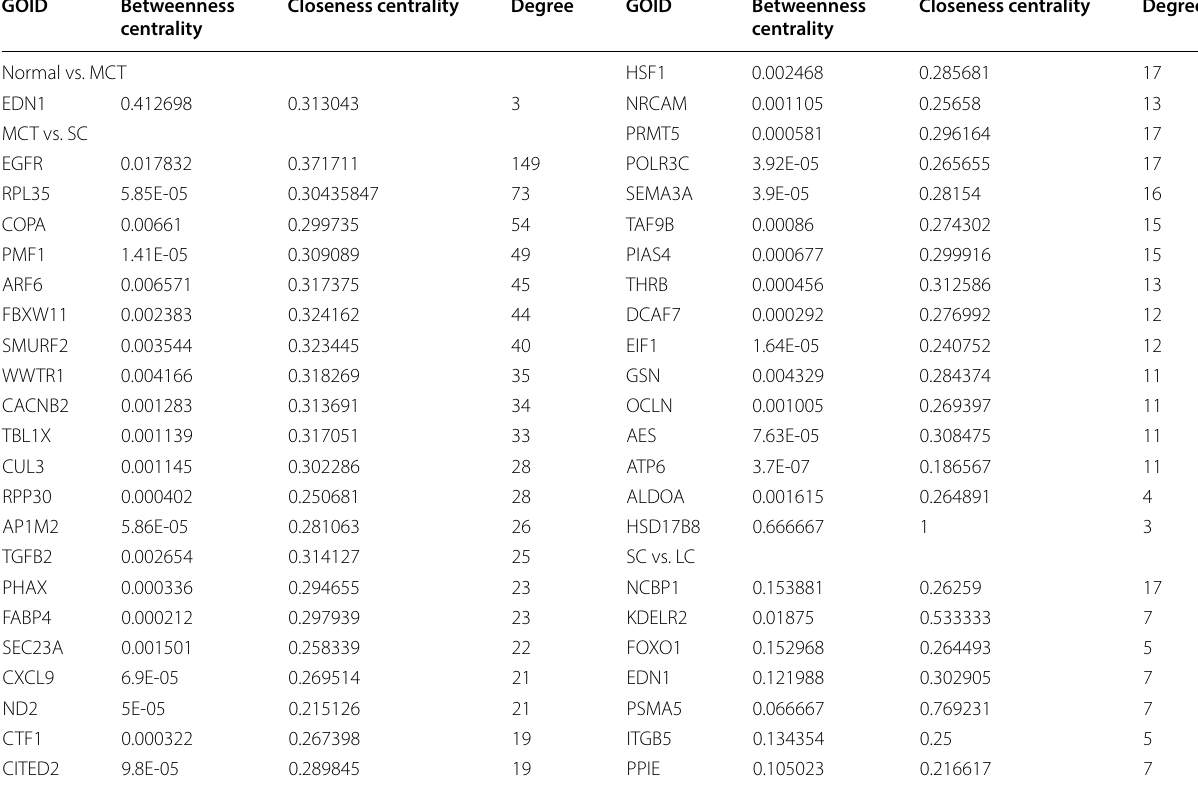
Closeness centrality Degree centrality